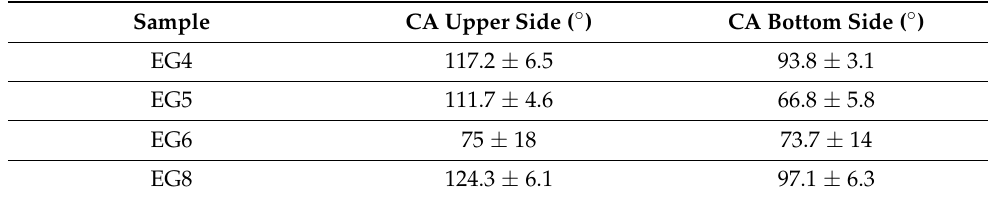
Table 3. Water contact angles measured on both sides of selected porous films.